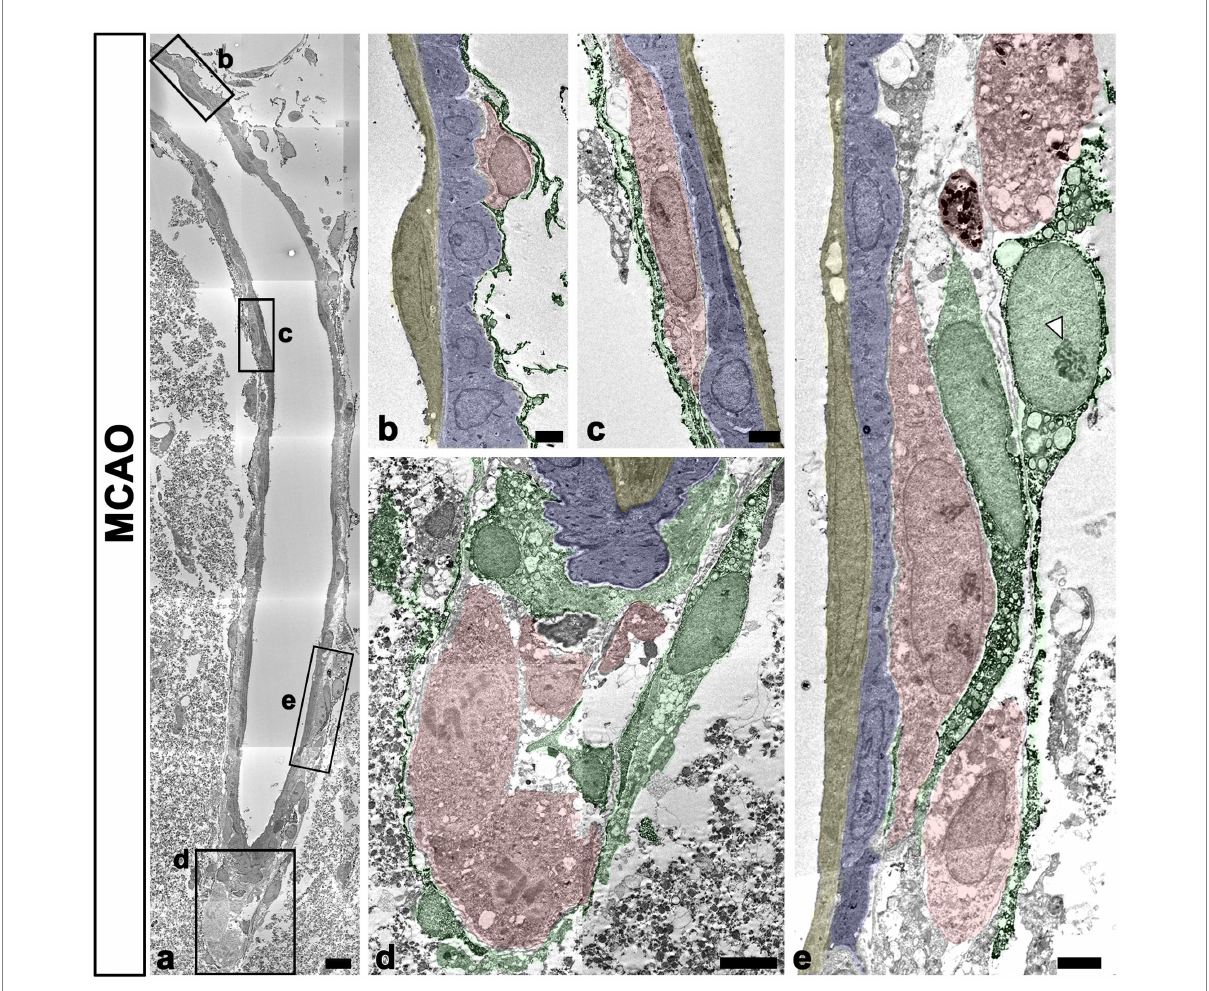
FIGURE 7 Ultrastructural characteristics of macrophages and PDGFR- β (+) cells within penetrating cortical vessels. (A) Lower magnification view showing the arteriole penetrating the ischemic cortex. The boxed areas in a are enlarged in (B–E) . Meningeal macrophages (shaded in red) are surrounded by a multilayered sheath of PDGFR- β -positive cells (shaded in green) that have euchromatic nuclei with prominent nucleoli (arrowhead in E ) and dilated cisternae of the rough endoplasmic reticulum. Note that macrophages are located on the abluminal side of smooth muscle cells (shaded in blue) and endothelial cells (shaded in yellow) of penetrating arteriole. Scale bar = 10 μ m for (A) ; 2 μ m for (B,C,E) and 5 μ m for (D)